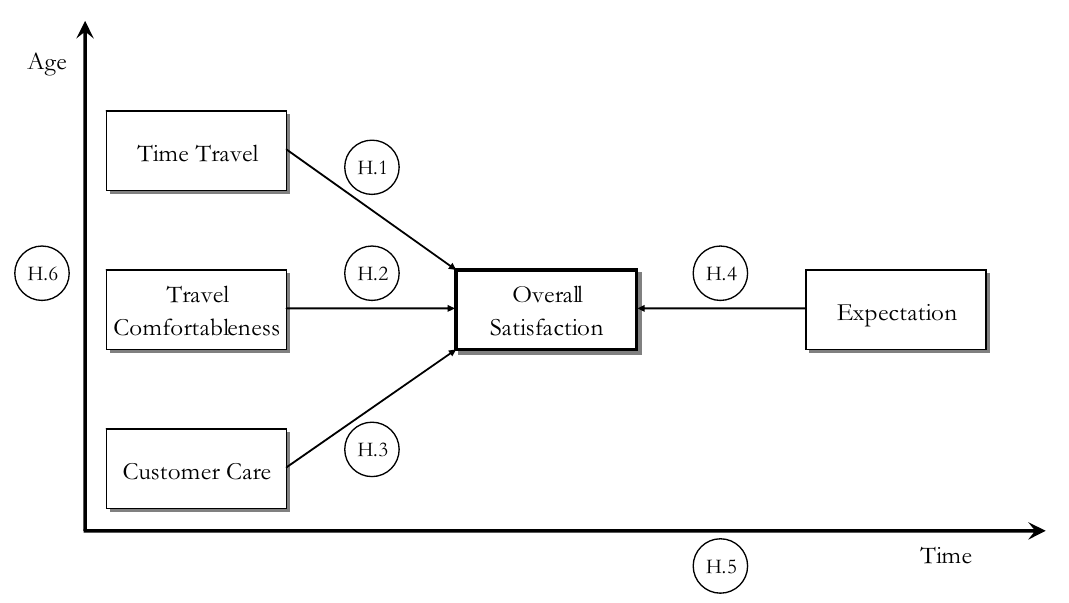
Figure 1 – Public transport conceptual model of Customer